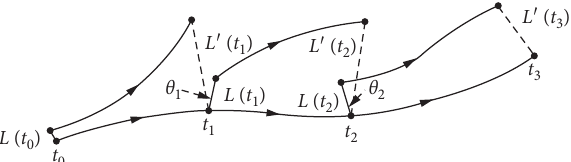
Figure 3: Schematic diagram of the Wolf method for calculating the maximum Lyapunov